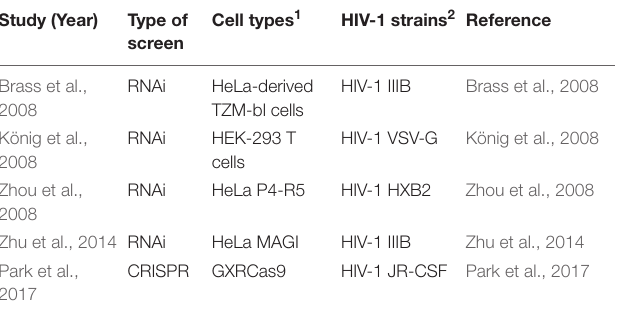
TABLE 1 | Summary of RNAi and CRISPR-Cas9 genome-wide knockout experiment characteristics for the study of HIV